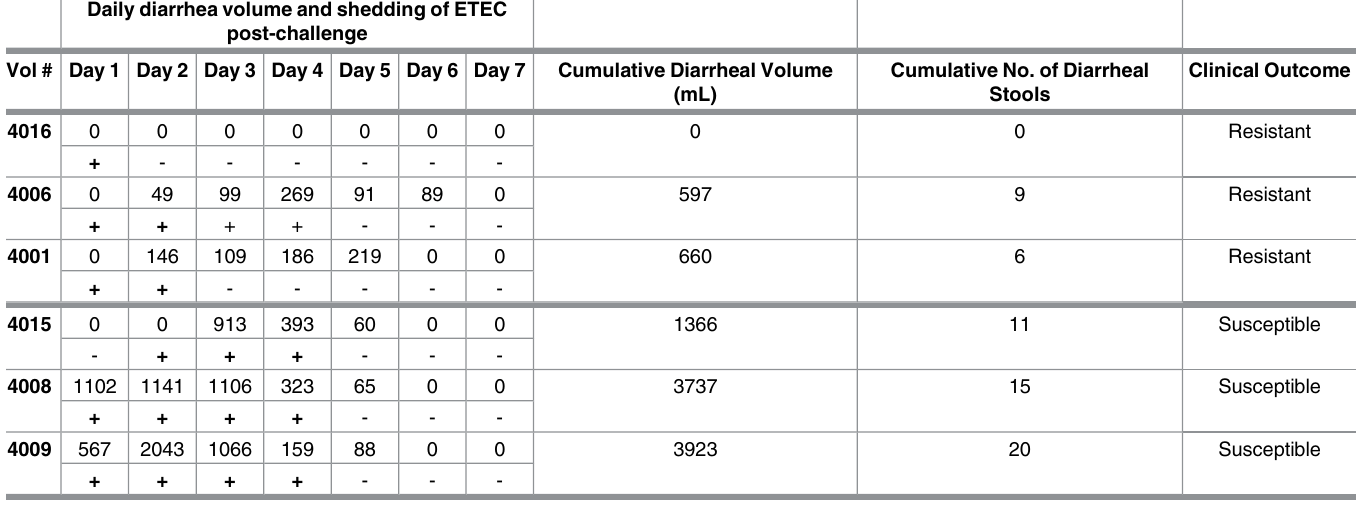
Table 1. Individual diarrheal purge to challenge. Daily diarrhea volume and shedding of ETEC